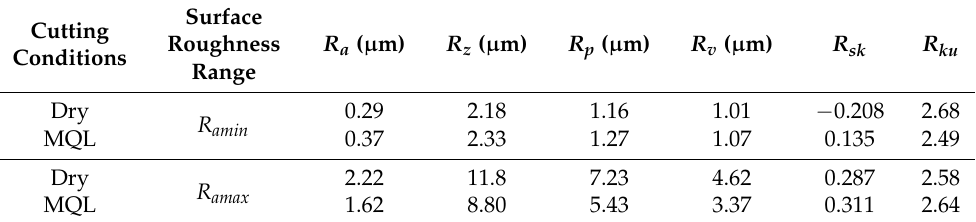
Table 2. Surface Roughness Parameters for Samples with R amin and R amax Obtained after Finish Turning.